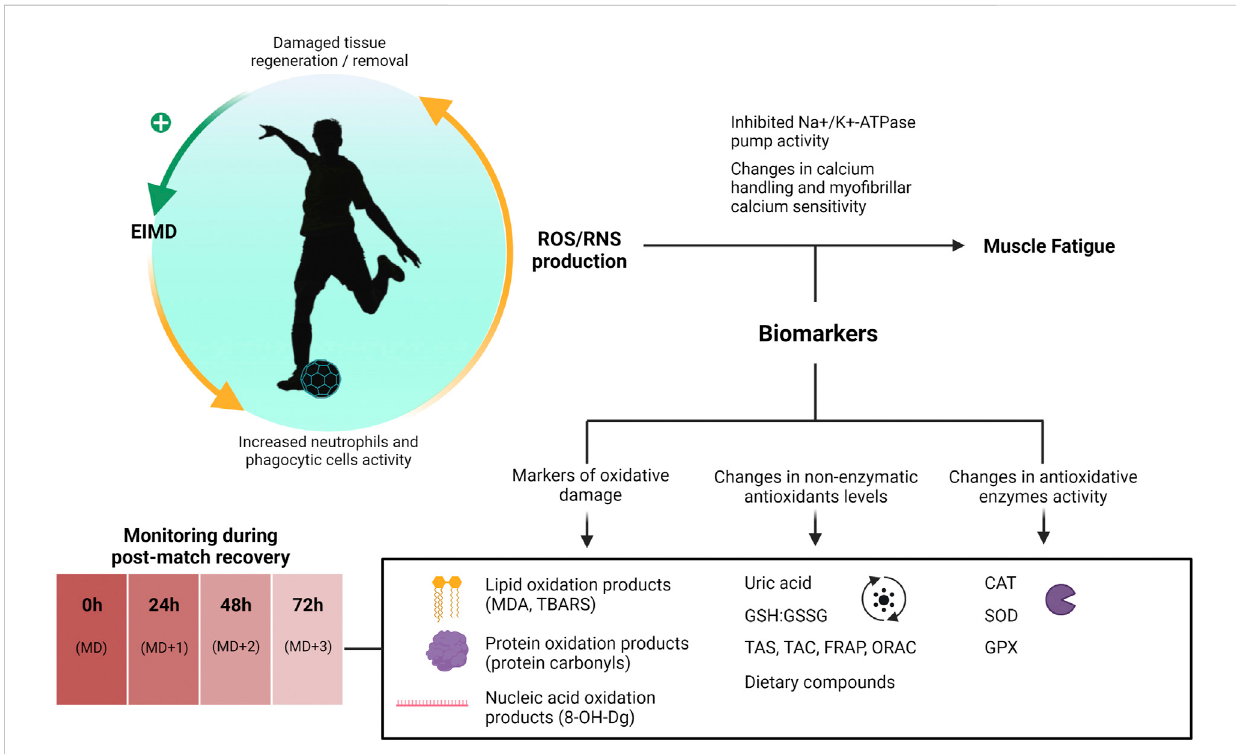
FIGURE 3 Biomarkers of oxidative status during post-match recovery. 8-OH-Dg, 8-hydroxy-2-deoxyguanosine; CAT, catalase; EIMD, exercise-induced muscle damage; FRAP, ferric reducing antioxidant potential; GHS:GSSG, glutathione to glutathione disul fi de ratio; GPX, glutathione peroxidase; MD, Match-day; MDA, malondialdehyde; ORAC, oxygen radical antioxidant capacity; RNS, reactive nitrogen species; ROS, reactive oxygen species; SOD, superoxide dismutase; TAC, total antioxidant capacity; TAS, total antioxidant status; TBARS, thiobarbituric acid reactive